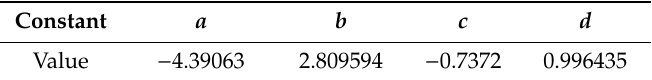
Table 1. Universal constants of Equation (3).